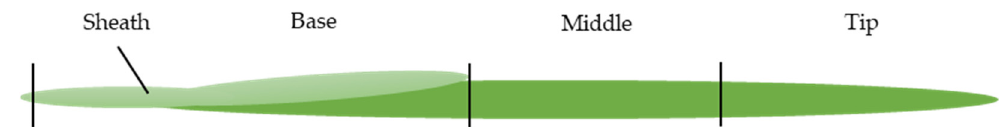
Figure 10. Schematic representation of rice leaf segmentation for analysis. Leaves were divided into sheath, base, middle and tip segments.